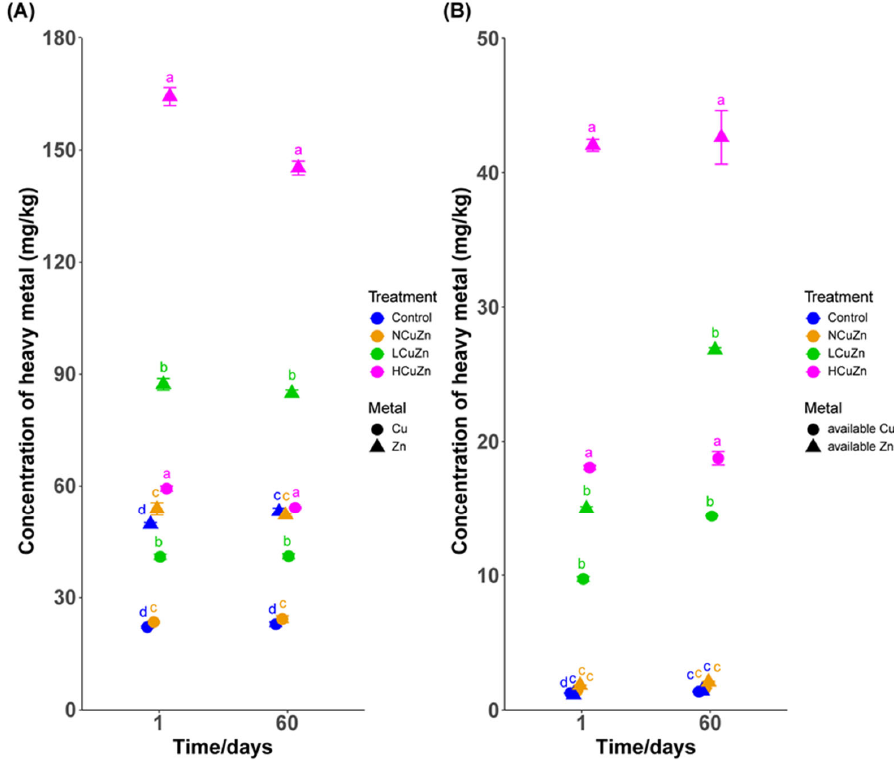
Figure 1. Heavy metal content in the experimental soils used in this study. ( A ) Total and ( B ) available Cu and Zn. Lowercase letters indicate statistical significance for treatment comparisons (ANOVA, p < 0.05).